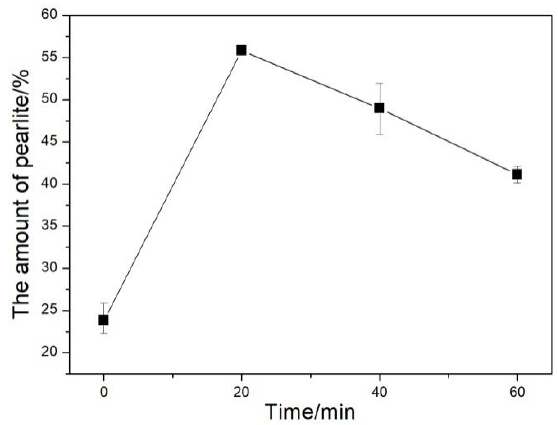
Figure 9. The amount of pearlite in DI after injecting nitrogen gas for different time periods.